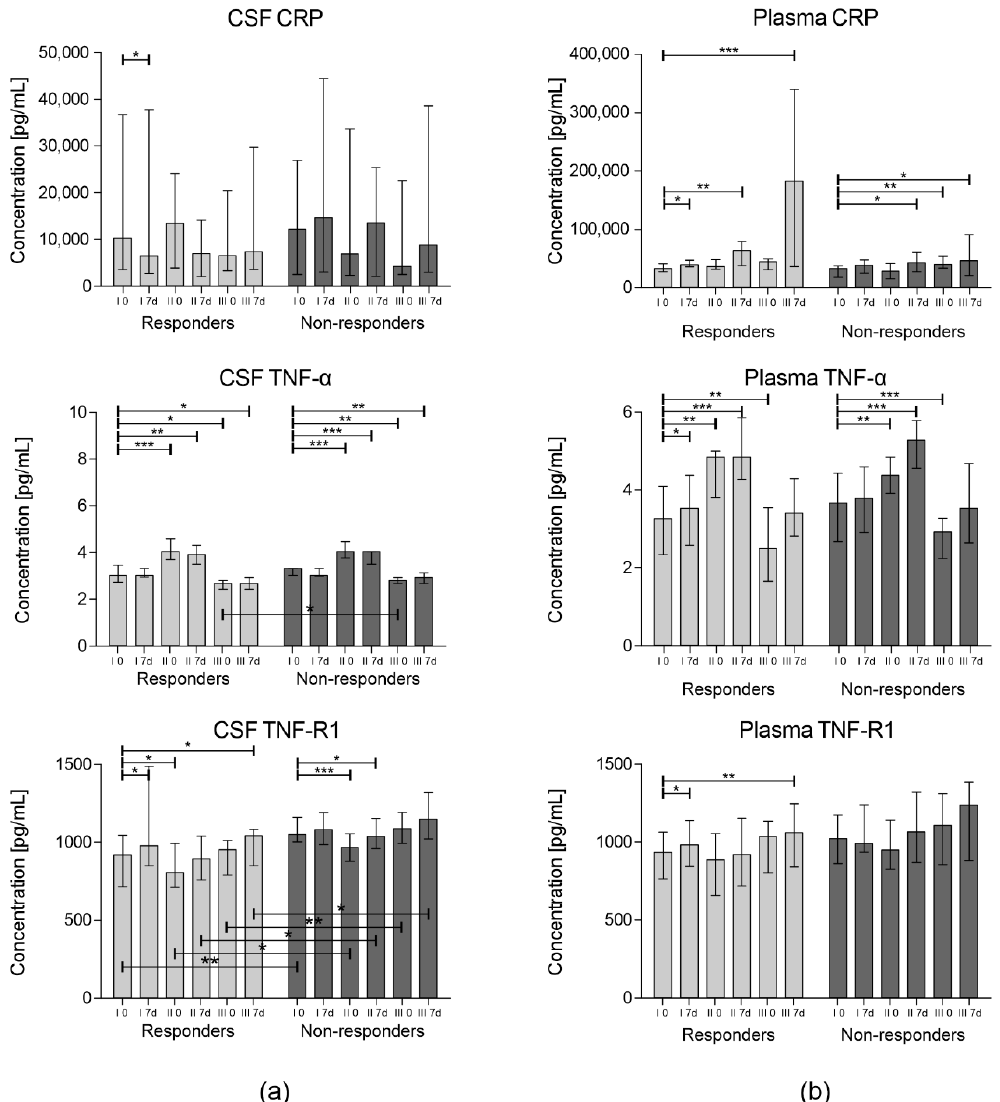
Figure 2. Concentration (pg / mL) of analyzed cytokines in the bodily fluids of ALS patients before (0) and one week after (7 d) each of the cell administrations (I, II, and III): ( a ) cerebrospinal fluid (CSF) concentrations; ( b ) concentrations in plasma. Data are presented as the median value with the interquartile range. Statistical testing between different timepoints in each of the analyzed groups (responders and non-responders) was performed using the Wilcoxon signed-rank test. To compare certain timepoints between the groups, the Mann–Whitney U test was applied. Level of significance—